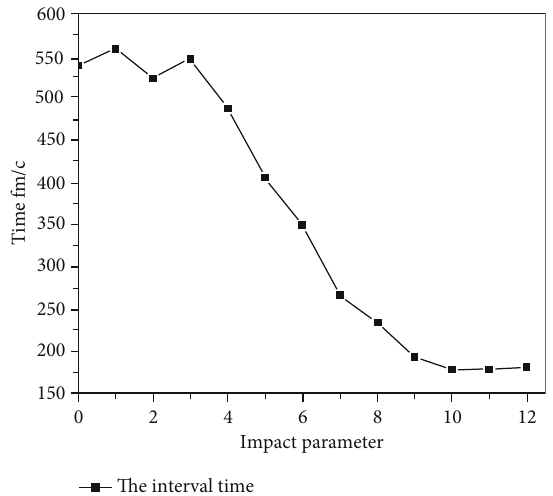
Figure 4: Correlation between the time interval Δ t and the impact parameter.